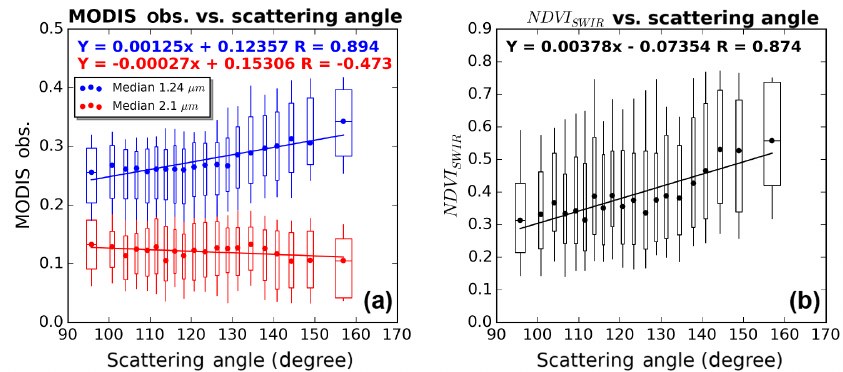
Figure 5. The dependence of the MODIS observation (obs. in a ) and NDVI SWIR (b) on the scattering angle. Blue and red indicate the observation at 1.24 and 2.12µm, respectively. Except for the color, other symbols are similar to Fig.